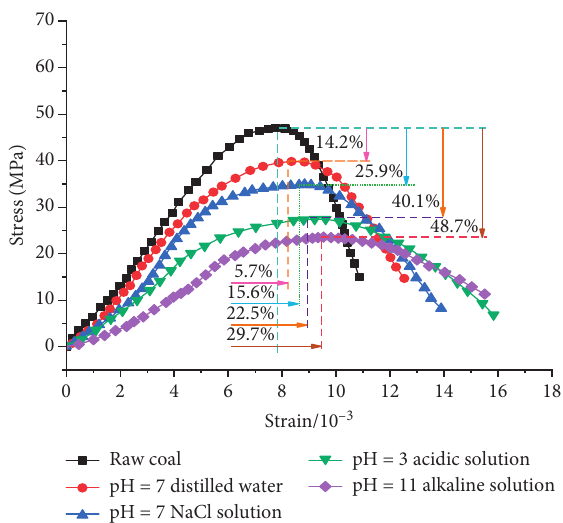
Figure 10: Dynamic stress-strain curves of specimens immersed in different chemical